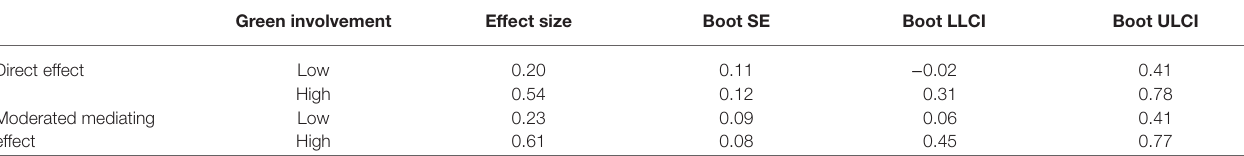
TABLE 5 | Mediating effect in different green involvement